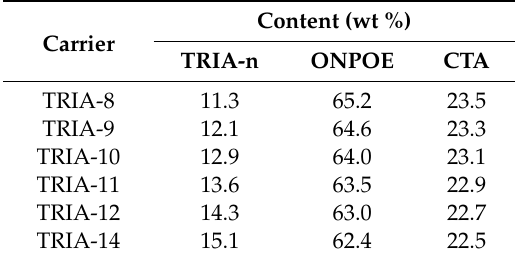
Table 2. Membrane composition (wt %).